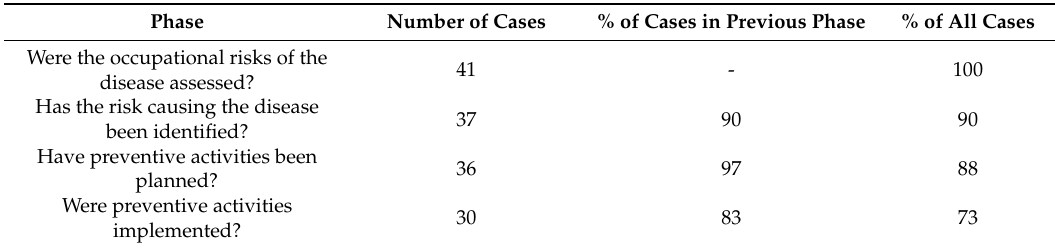
Table 8. Prevention cycle performance. These questions are regarding the activities performed before